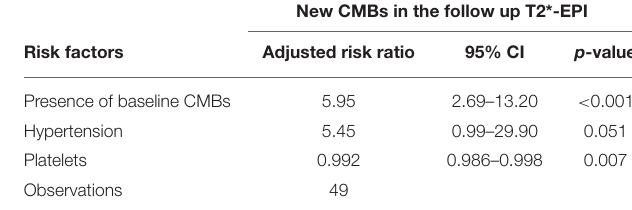
TABLE 6 | Multiple logistic regression analysis for new CMBs in the follow-up T2*-EPI. New CMBs in the follow up T2*-EPI